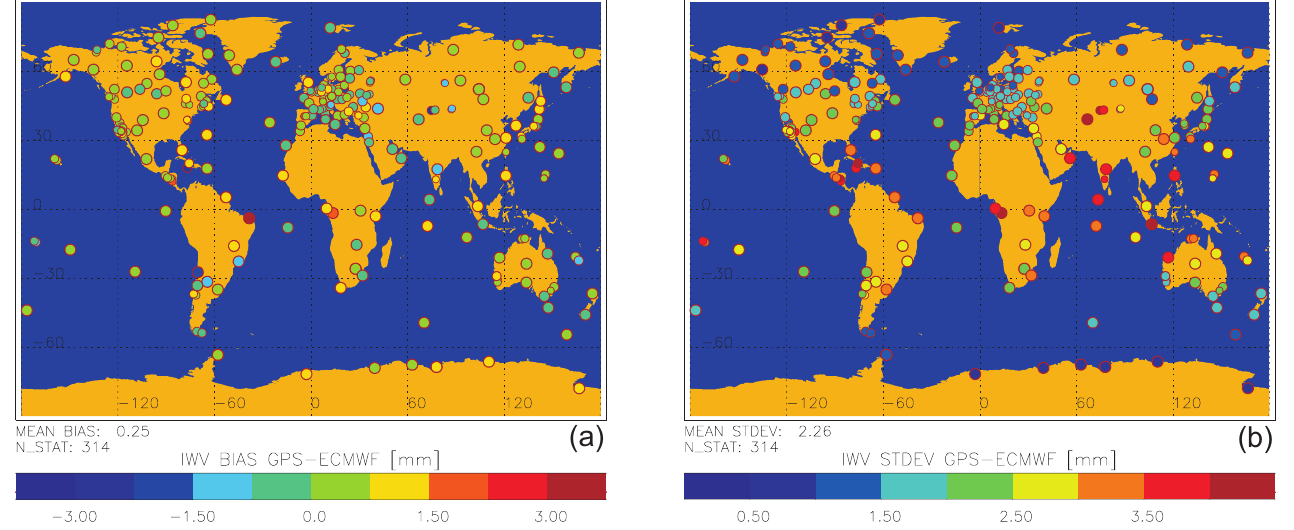
Fig. 4. GPS IWV results 2000–2007 from stations with more than one year of data in comparison with IWV from ECMWF at 00:00, 06:00, 12:00, 18:00UT (time of ECMWF analyses): (a) bias, (b) standard deviation. Size of station symbols depends on distance from neighbouring stations.